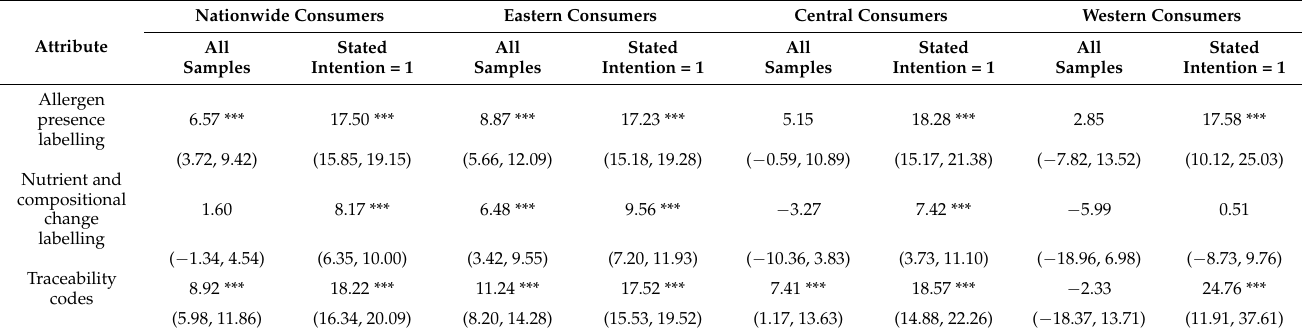
Table 5. Willingness to pay for a premium for enhanced mandatory labeling information of the GM soybean